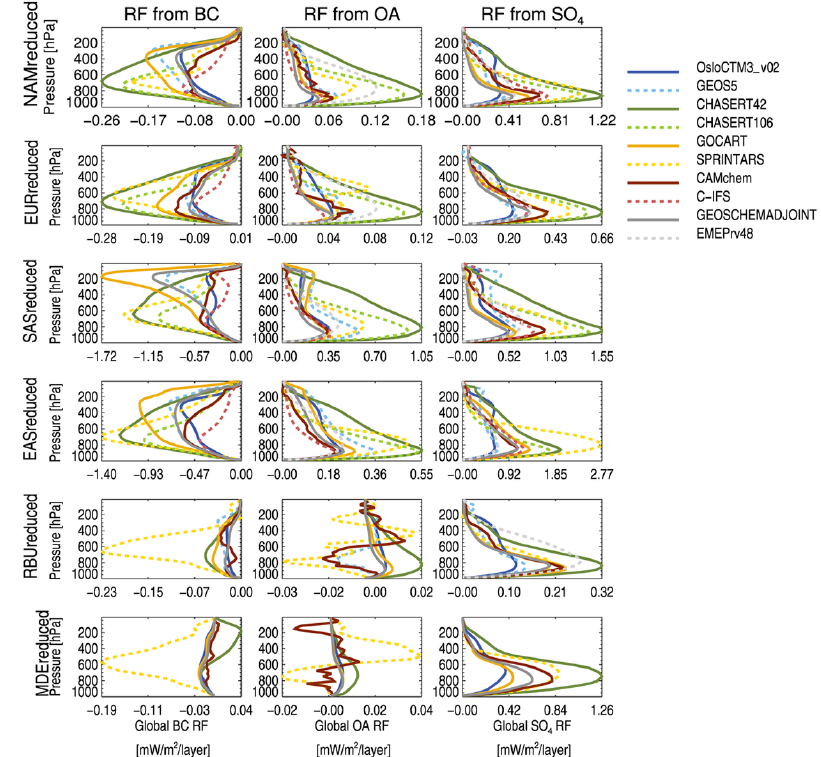
Figure 8. Global mean vertically resolved aerosol direct radiative forcing, when reducing emissions by 20% within the region indicated (rows), for all aerosol species (columns). Each line represents one model. See Tables S2 to S4 for individual model results.